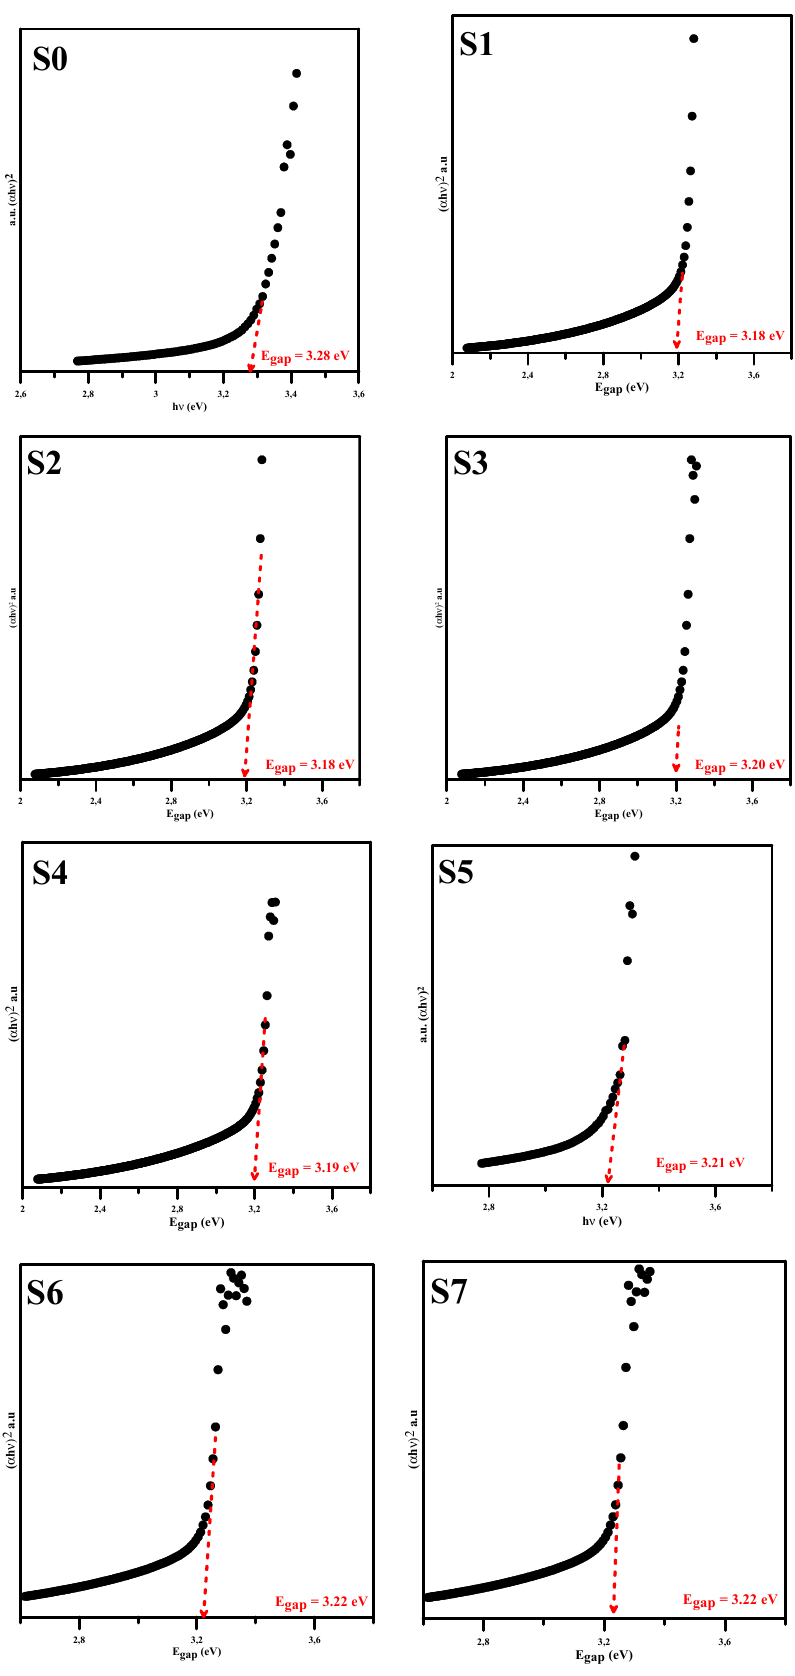
Figure 8. The optical band gap energy of the pure and boron doped ZnO thin films.